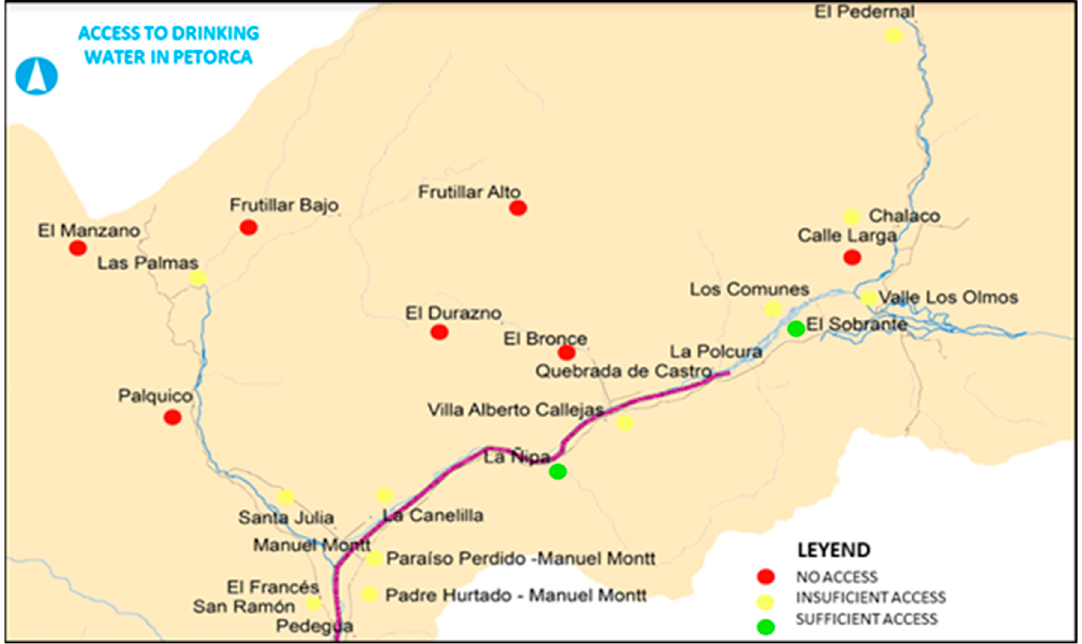
Figure A1. Access to drinking water in Petorca, considering the situation up to December 2019. Source: Water Resources Office, Municipality of Petorca, Chile [61].